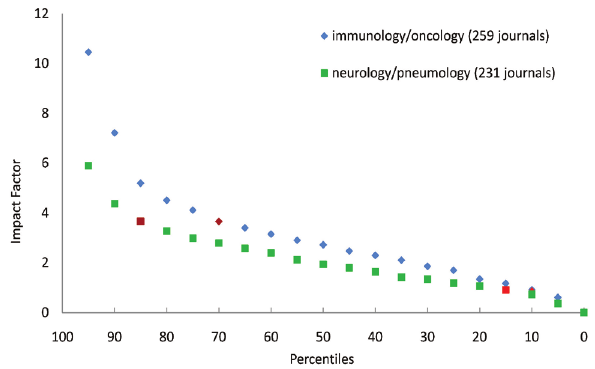
Figure 5 - Impact factor as a function of percentile for selected subject categories of the ISI collection.